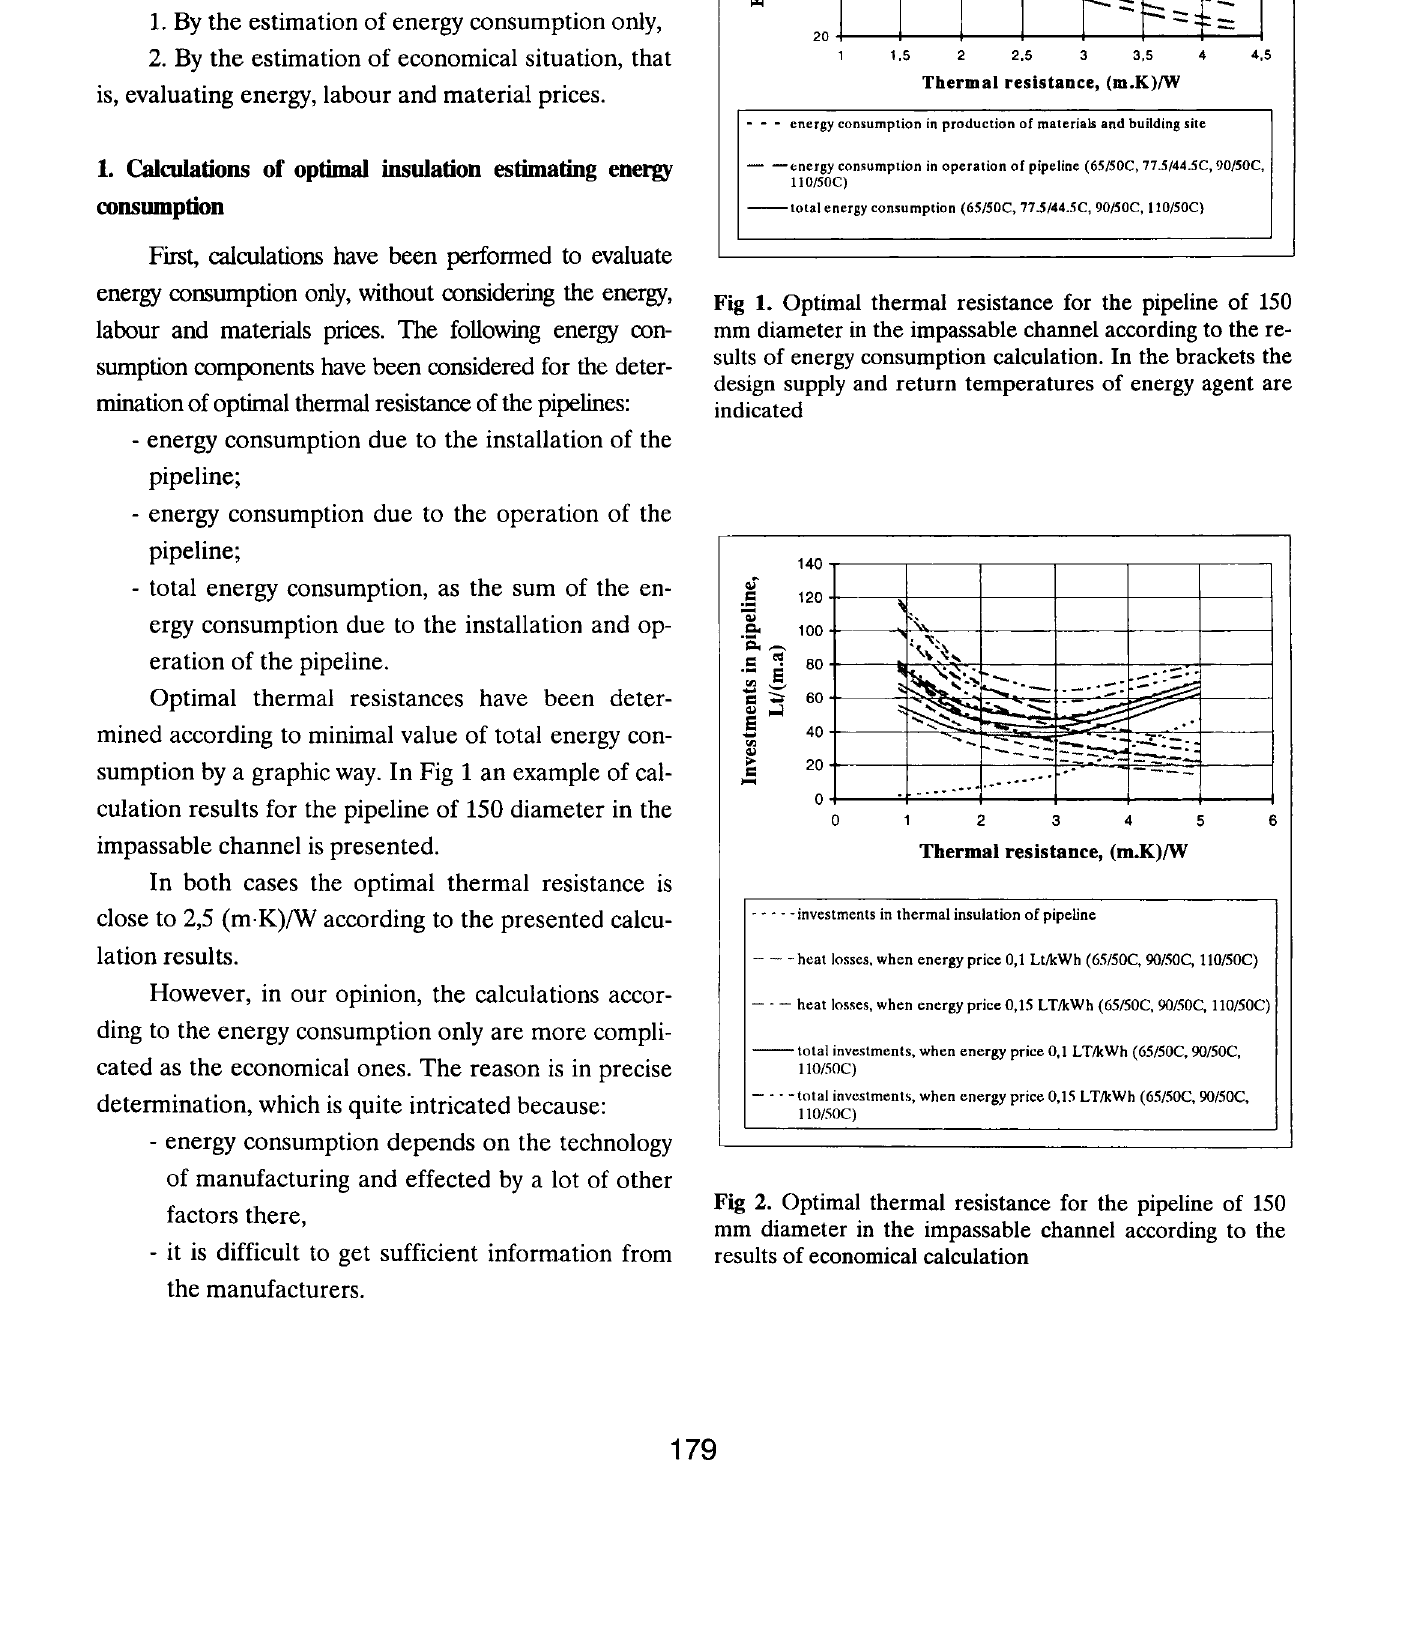
Fig 1. Optimal thermal resistance for the pipeline of 150 mm diameter in the impassable channel according to the re sults of energy consumption calculation. In the brackets the design supply and return temperatures of energy agent are indicated